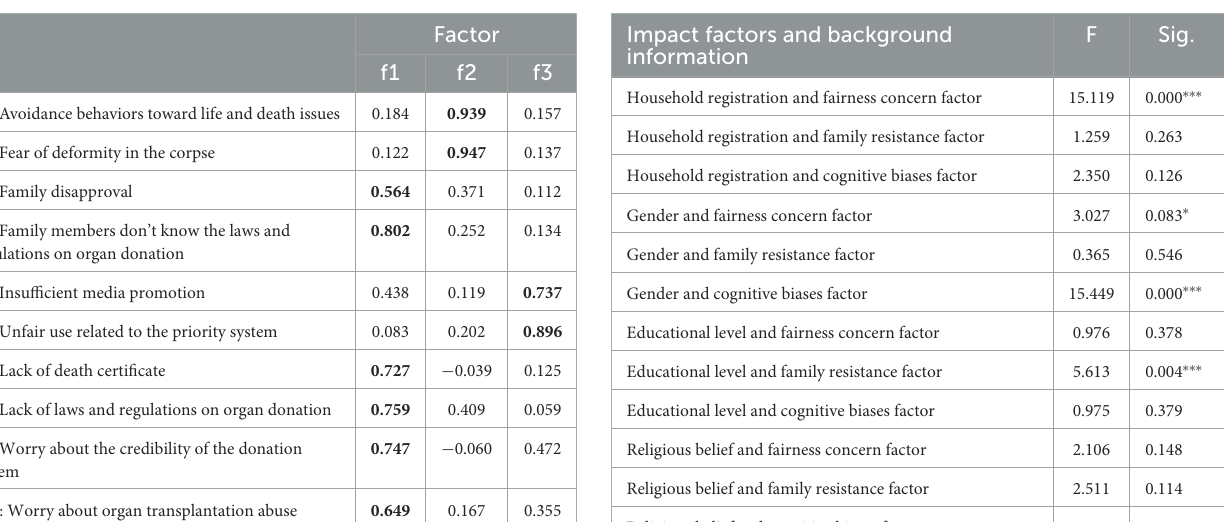
TABLE 12 Rotated component matrix (unwillingness to be an organ donor).